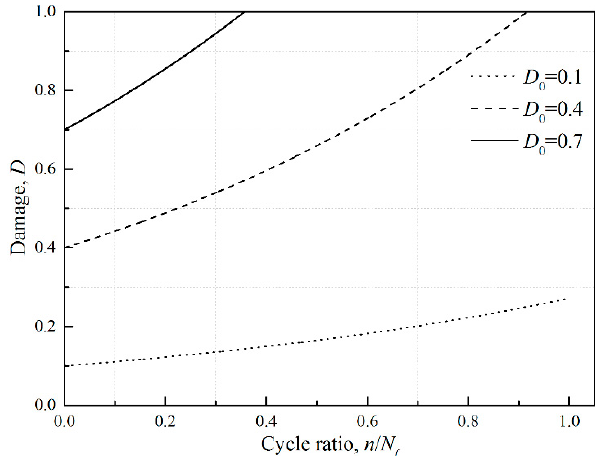
Figure 2. Damage curves under loads below fatigue limit with different initial damages.